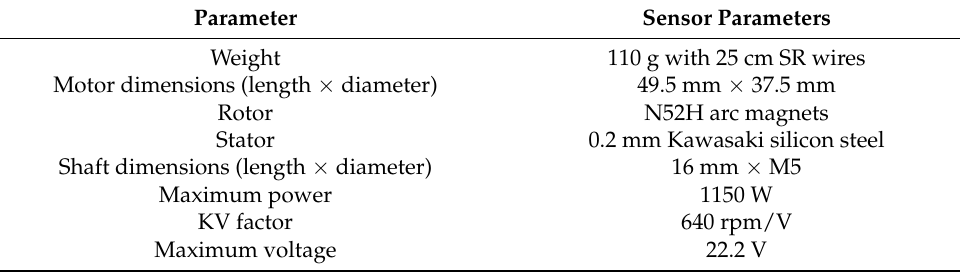
Figure 8. BrotherHobby Tornado T5 3115 electric motor [42]. Table 3. Technical parameters of the tested motor.